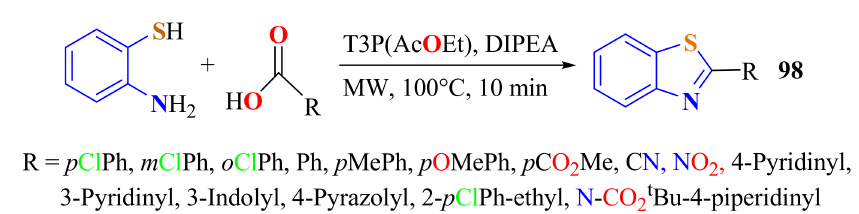
Scheme 80. Cathalysed condensation of ATP with aromatic and aliphatic carboxylic acids under MWI. The same procedure was used to prepare 2-( para -pyridyl)BT ( p -PBT) and 2-( para - pyridyl)BT N-oxide (2-(N-O p -PBT). The synthesized PBTs were used as ligands to react with metal ions such as Co(II), UO 2 (II), Sm(III), Eu(III), and Zn(II)) to afford a series of metallic complexes [190]. The photoluminescence properties of Samarium and Europium complexes were studied. Panda et al. discovered that an excess of ATP (10 equiv.) and benzoyl benzotria- without any catalyst or solvent used to produce 2-substituteBTs 99 (Scheme 81). The liq- conventional heating was less efficient [191].